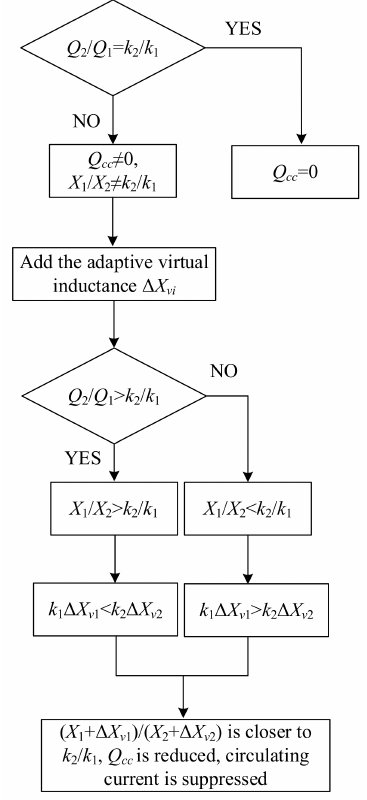
Figure 4. Working flow chart of adaptive virtual inductance control method when two inverters operated in